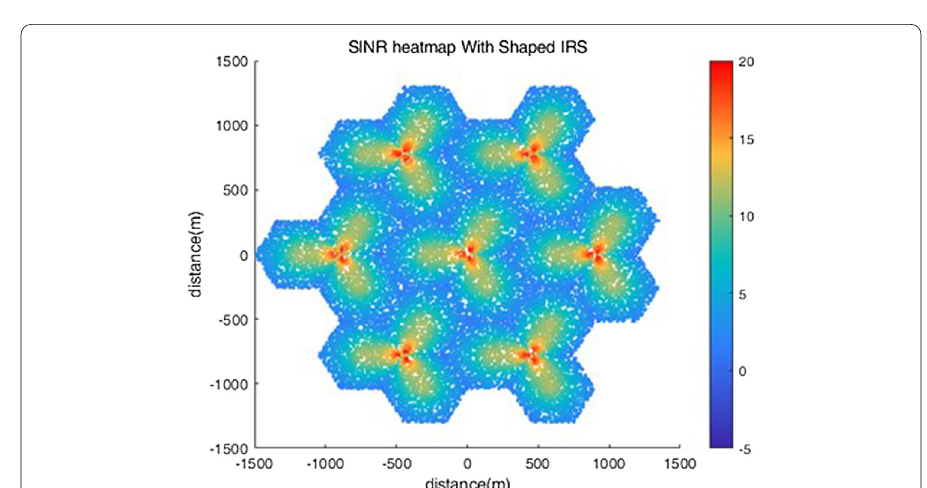
Fig. 9 Heatmap with shaped IRS. From the figure, it can be seen that the received SINR of UE has